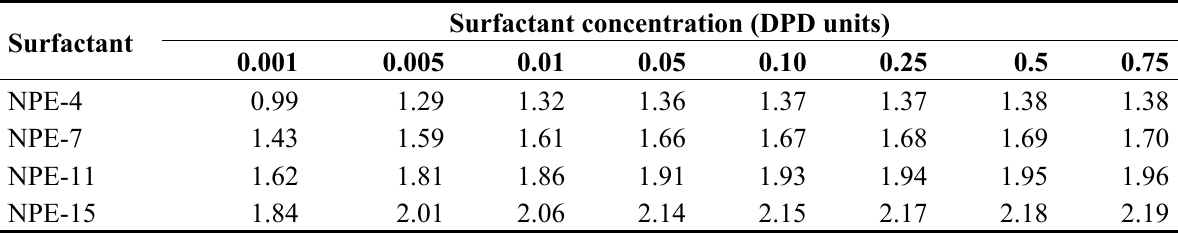
Table 3. Average end-to-end distance of NPE